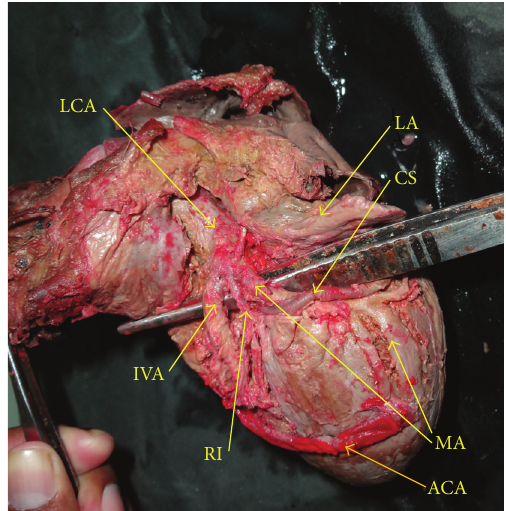
Figure 2: Showing trifurcation of left coronary artery. LA: left auri- cle, IVA: anterior interventricular artery, CS: coronary sulcus, RI: ramus intermedius, MA: marginal artery, ACA: accessory coronary